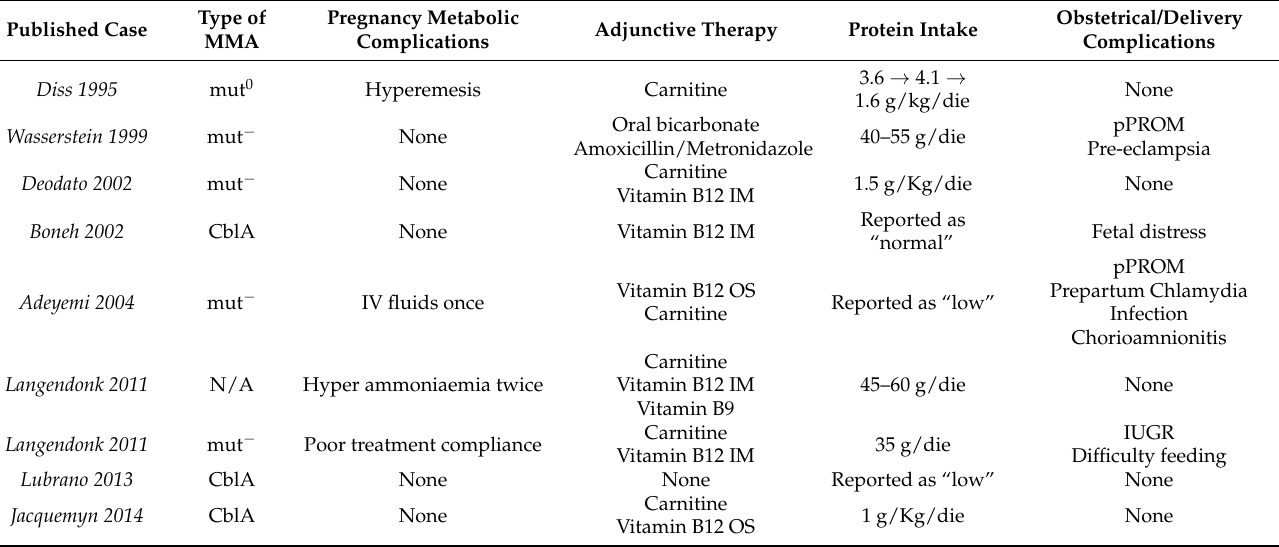
Table 1. Characteristics of the published mothers with methylmalonic